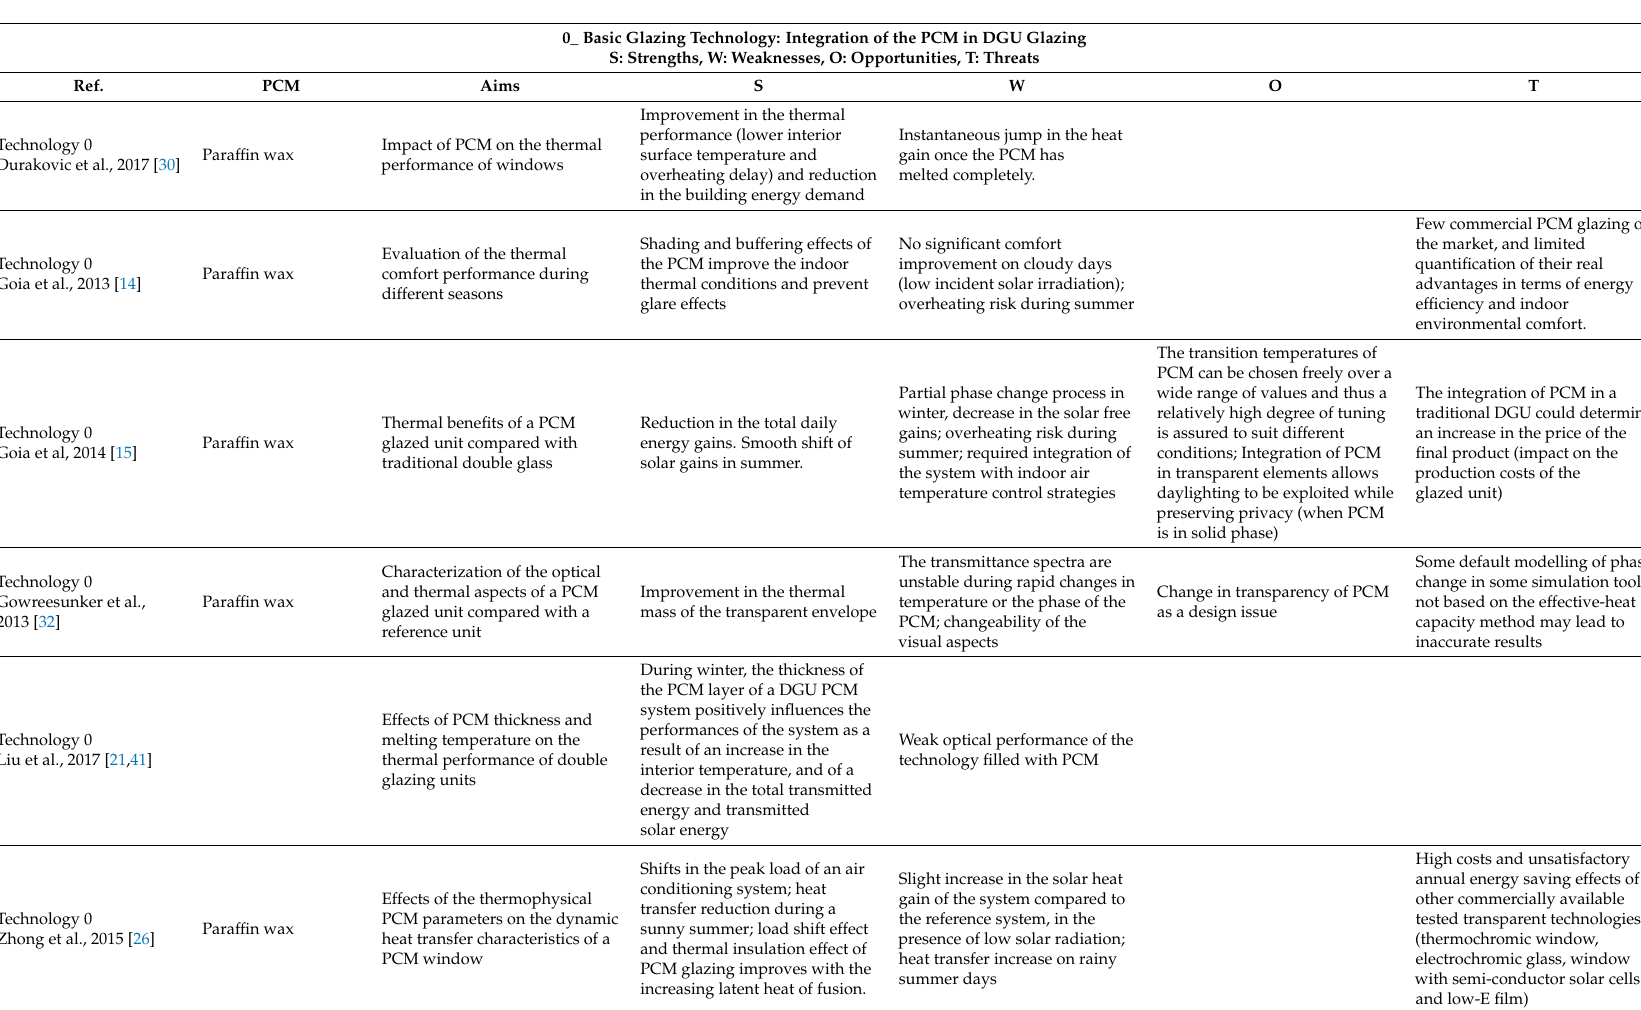
Table 2. SWOT analysis of PCM in DGU